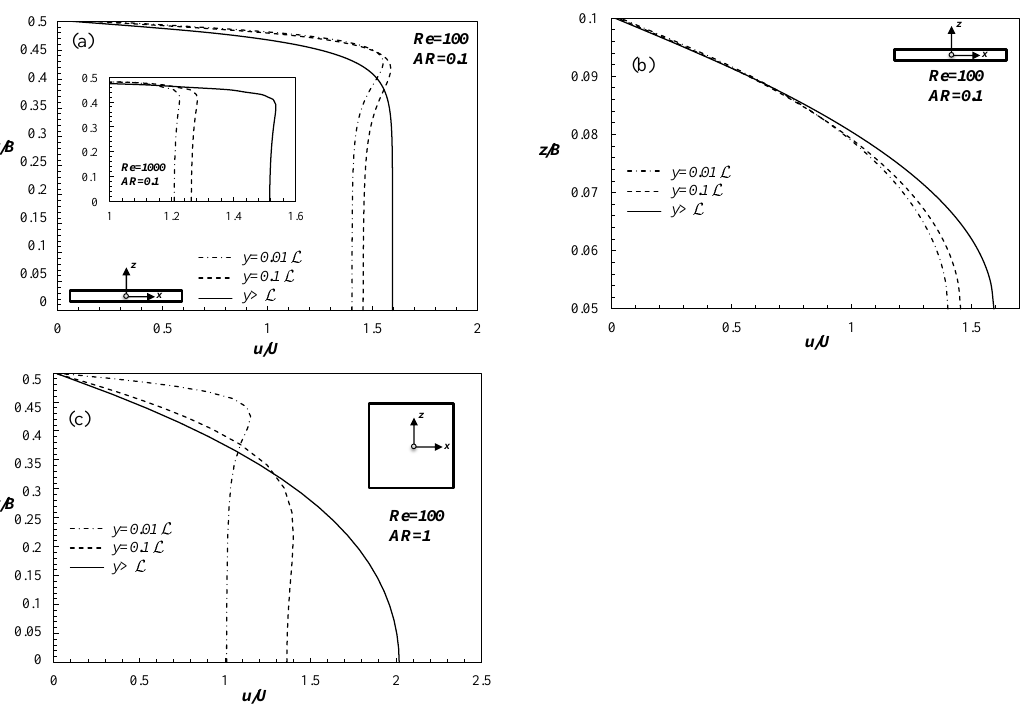
Figure 4. Velocity profiles obtained for AR = 0.1 ( a ) and AR = 1 ( c ) in the x − plane, for Re = 100 and different y positions along the microchannel ( z = 0). The inset in ( a ) shows the velocity profiles obtained for the case Re = 1000. ( b ) Velocity profiles obtained for AR = 0.1 and Re = 100 in the z − plane, for different y positions along the microchannel ( x =